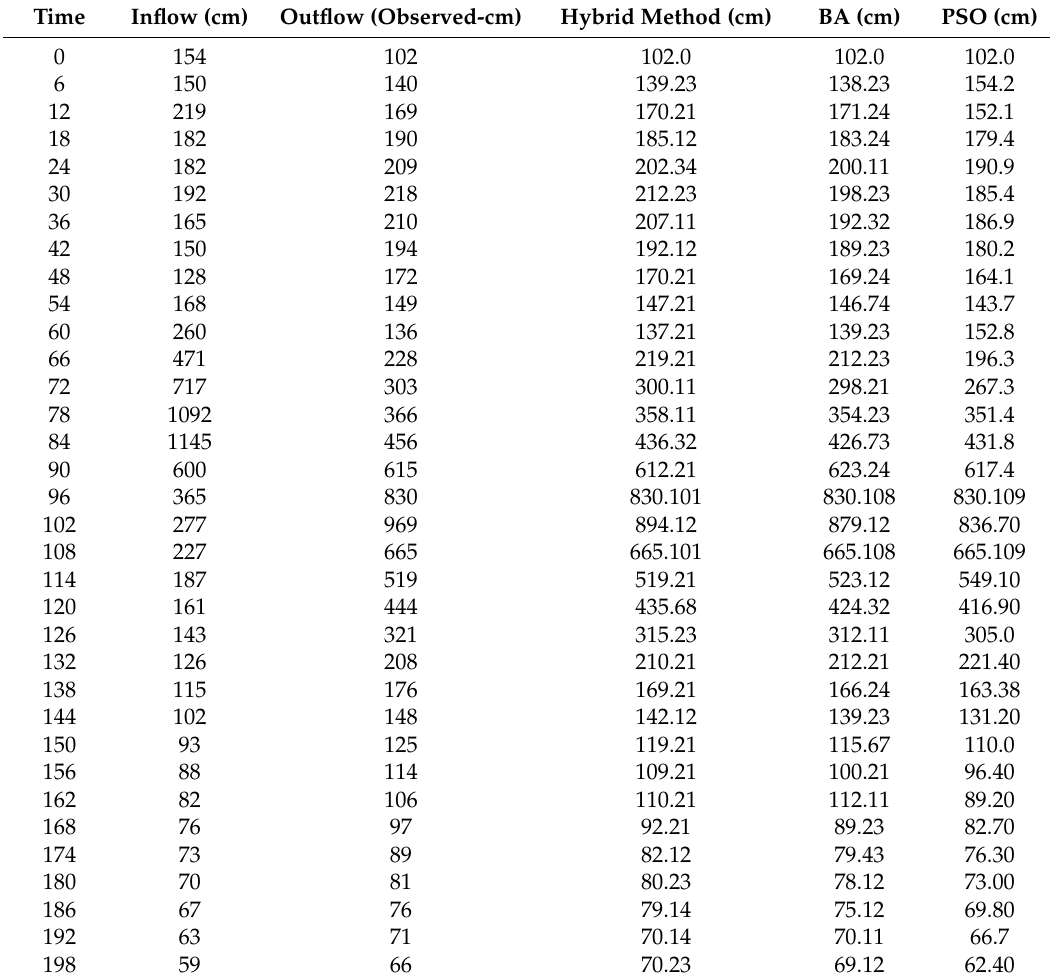
Table 11. The inflow and outflow for flood